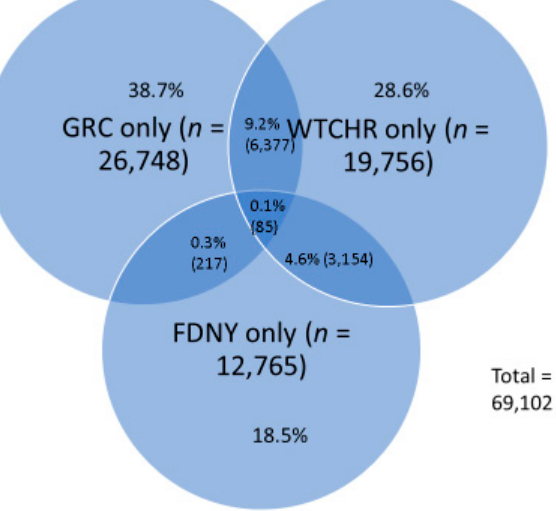
Figure 2. Overlap between the three cohorts after de-duplication and combining.